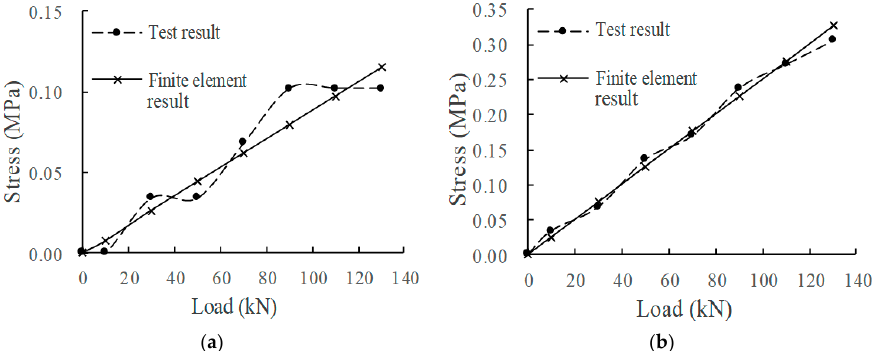
Figure 12. Base slab stress: ( a ) 0 million times of train load; ( b ) 30 million times of train load.